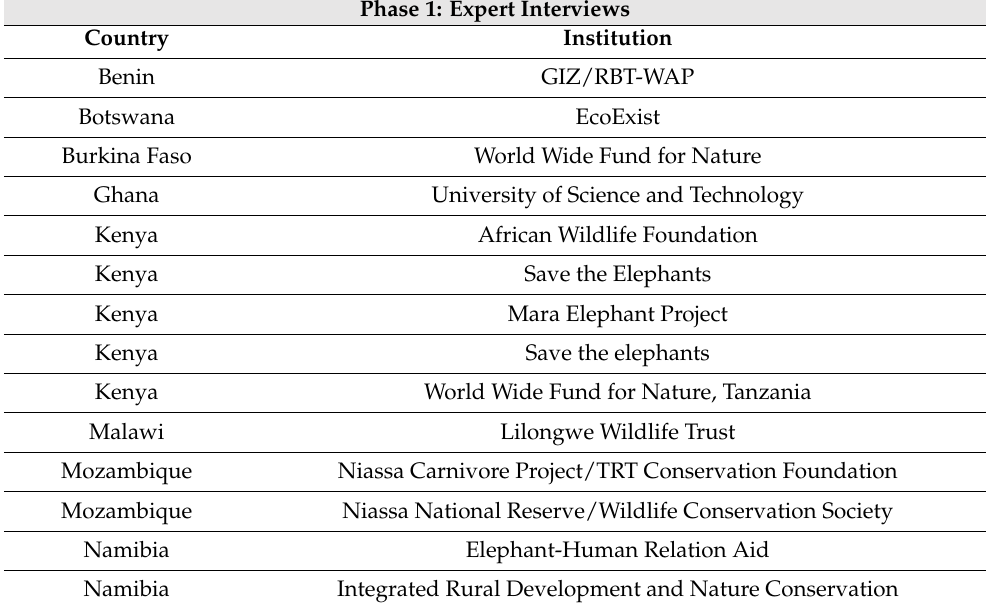
Figure 2. African Elephant Range 2015, which includes known, possible, and doubtful ranges [13], locations of expert interviewees of this study—phase 1 (green dots), and study areas for adaptation and validation of experts interviewees—phase 2 (stars markers). Table 1. Qualitative information sources in phase 1 (framework development), expert interviews.